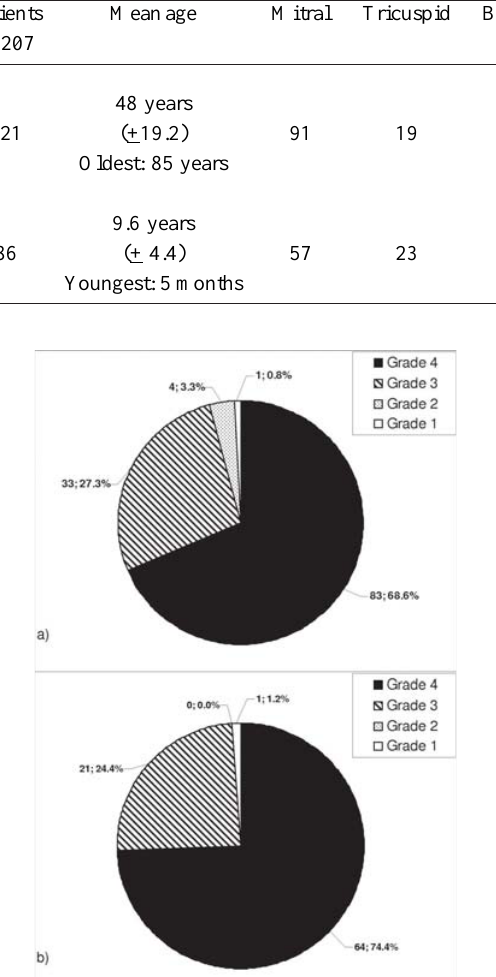
Fig. 1 – A: Chart showing the preoperative the New York Heart Association functional class (NYHA) of the adult population. B: Chart showing the preoperative New York Heart Association functional class (NYHA) of the pediatric